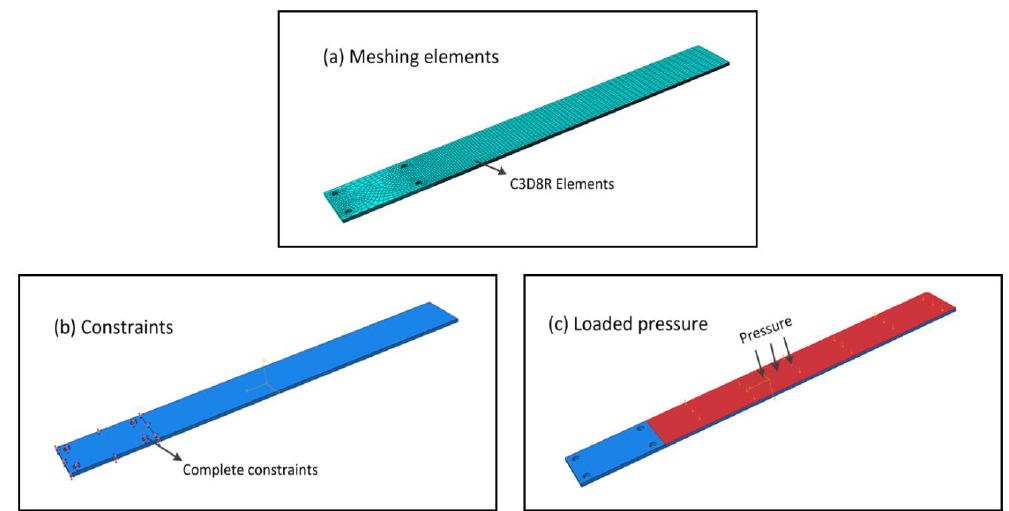
Figure 3. Meshing elements, constraints and loaded pressure in frequency response simulations. ( a ) Meshing elements, ( b ) Constraints, ( c ) Loaded pressure.